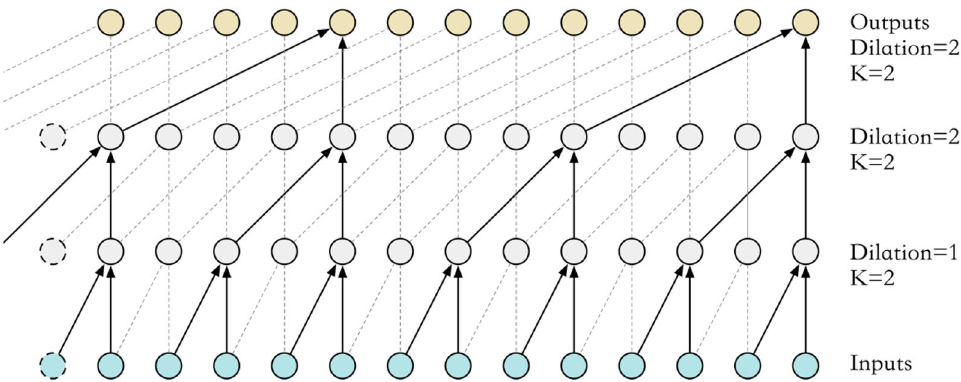
Figure 2. Causal dilated convolutional structure.